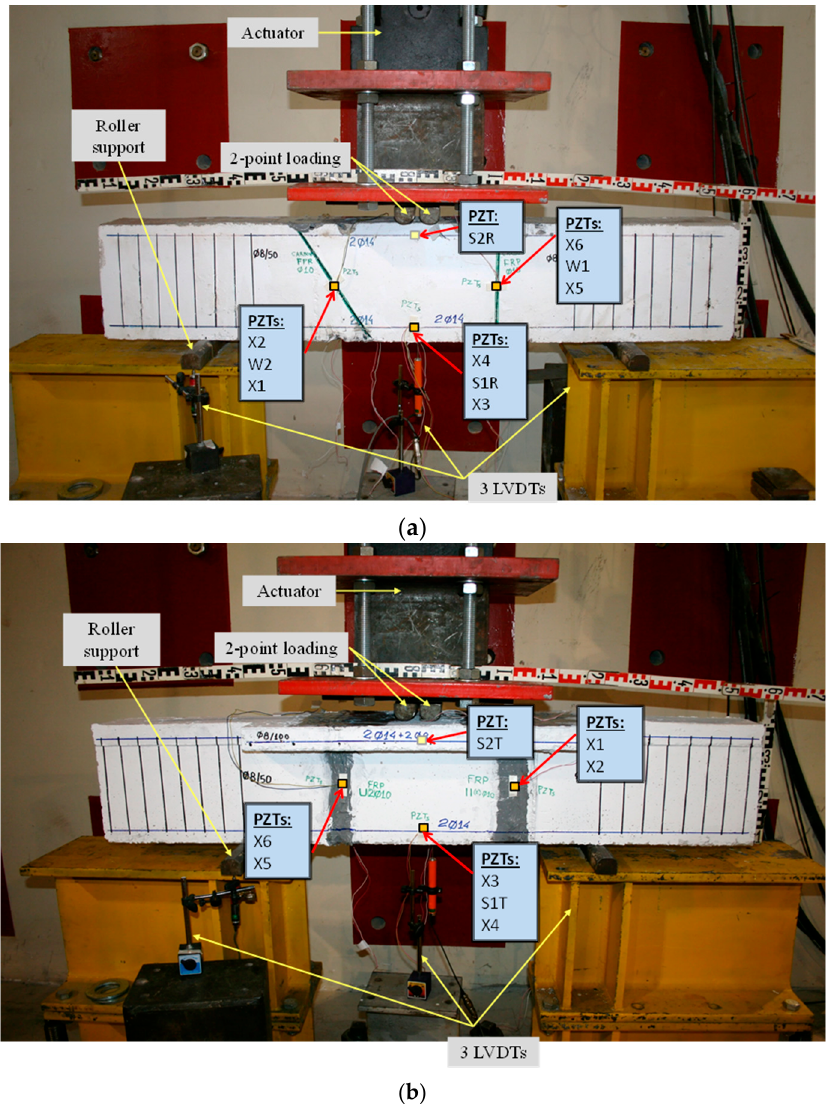
Figure 3. Test setup and instrumentation. ( a ) R-FRP deep beam with a rectangular cross-section and ( b ) T-FRP deep beam with a T-shaped cross-section.